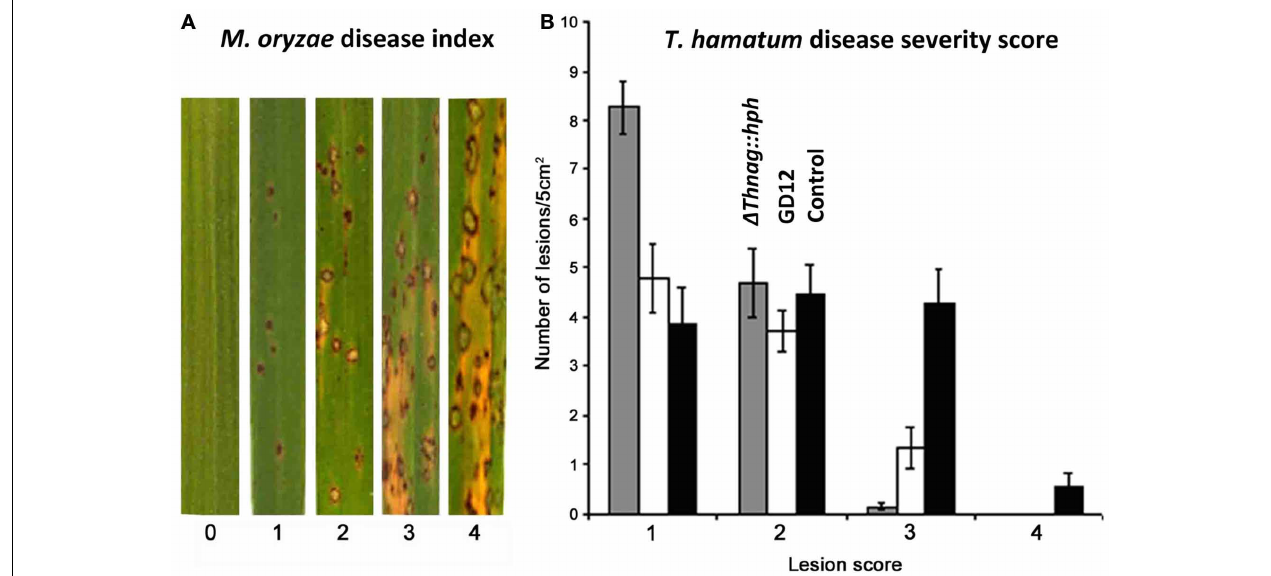
FIGURE 3 | T. hamatum biocontrol and plant disease suppression. (A) Leaf segments of rice (cultivar CO-39) showing rice blast symptoms. (B) Suppression of rice blast disease by T. hamatum . Growth of rice cultivar CO-39 in soil amended with T. hamatum GD12 (white bars) and the N -acetyl- β -D-glucosaminidase deficient mutant (cid:2) Thnag1::hph (gray bars) reduced the size of the lesions caused by